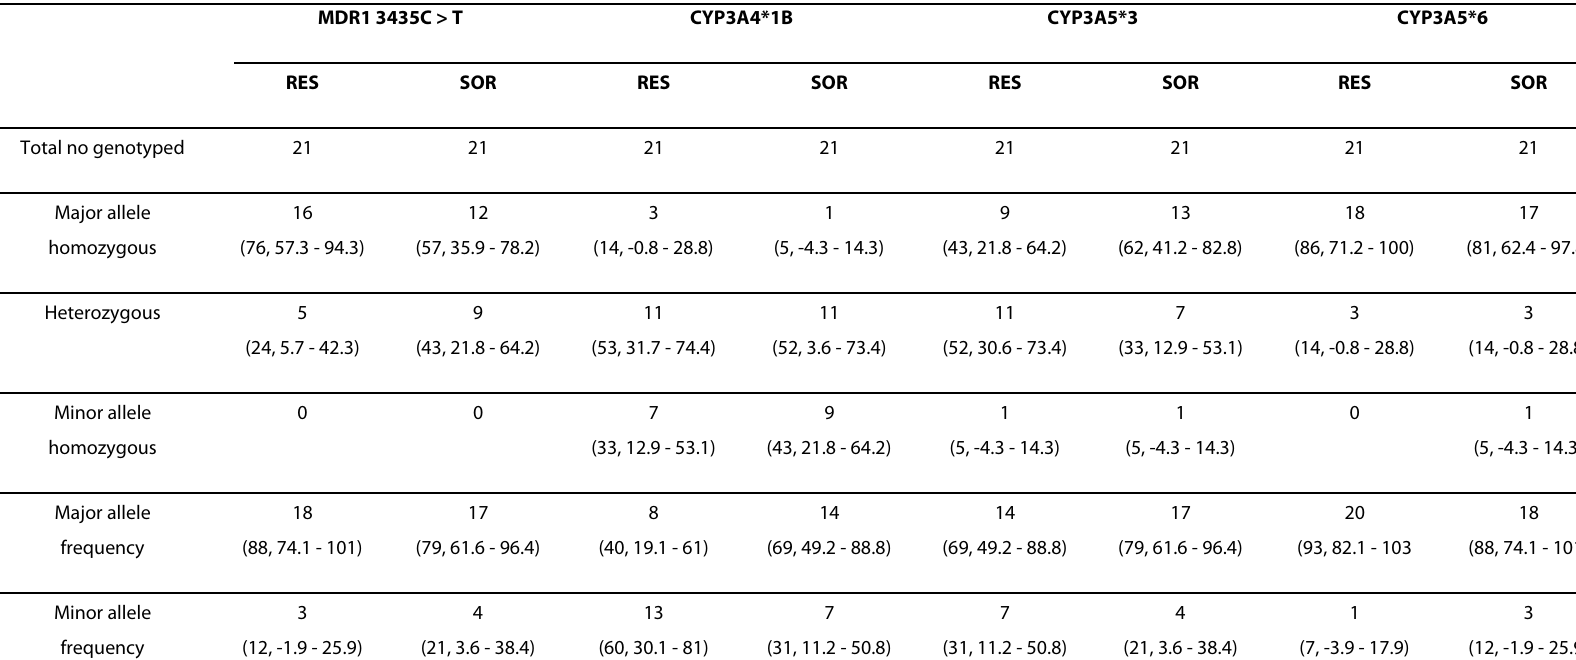
Table 2: Allele and Genotype frequencies for the MDR1 and CYP3A observed in IVM treated subjects (%, 95% CI in